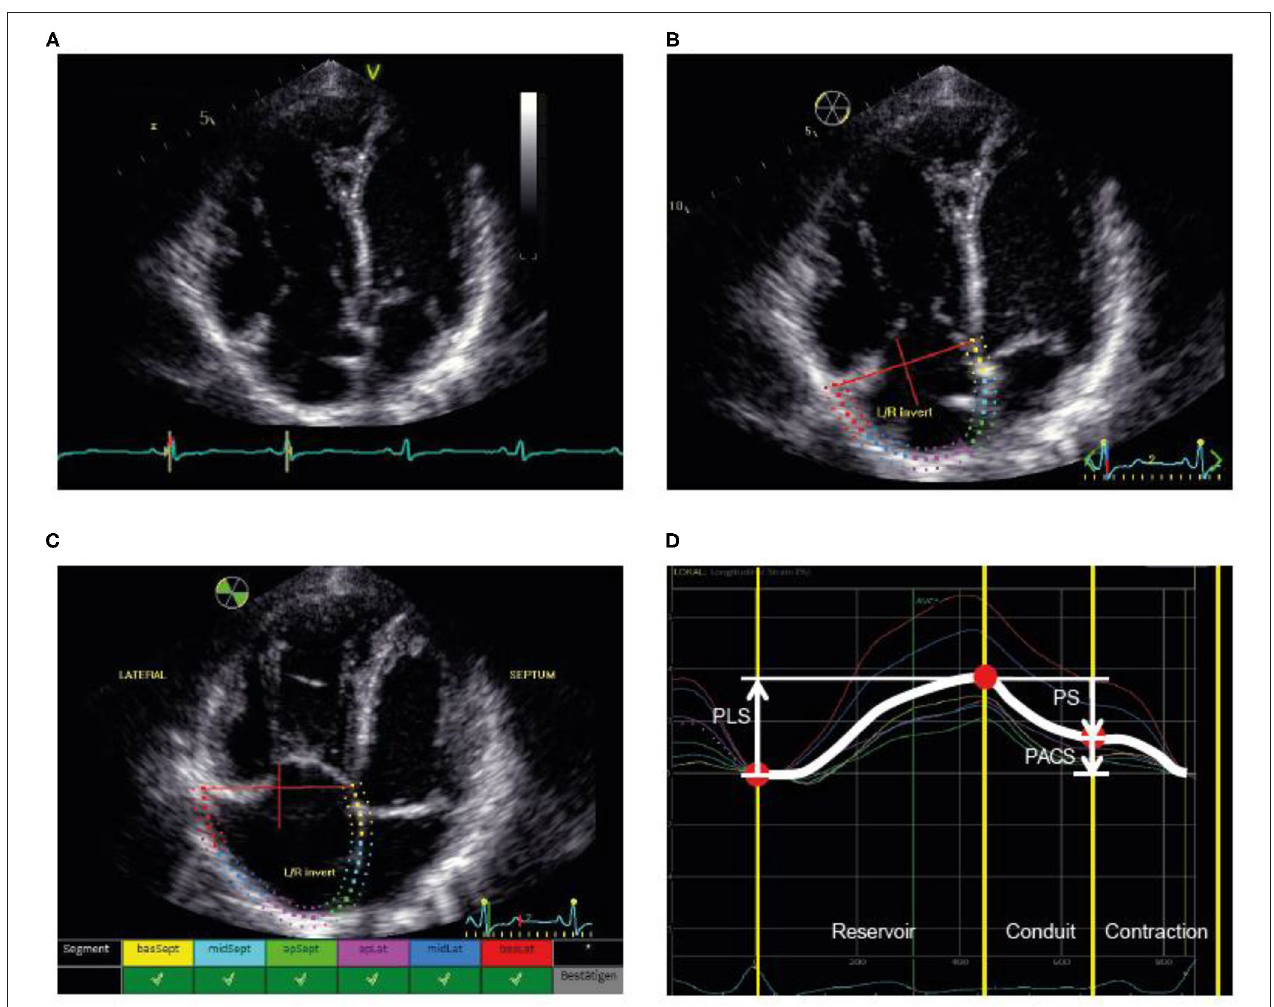
FIGURE 1 | Illustration of the assessment of RA strain. (A) First, the RV-focused apical four-chamber view was used with selection of the cardiac cycle and adjustment of the electrocardiogram (to R-wave). (B) Second, the RA endocardial border was traced as the region of interest, covering the RA lateral wall, roof, and septal wall. (C) Third, processing provided an overview wherever speckle tracking was feasible for the selected regions. (D) Fourth, the different phases were identified and the strain values determined. PACS, peak active contraction strain; PLS, peak longitudinal strain; PS, passive strain; RA, right atrial; RV, right